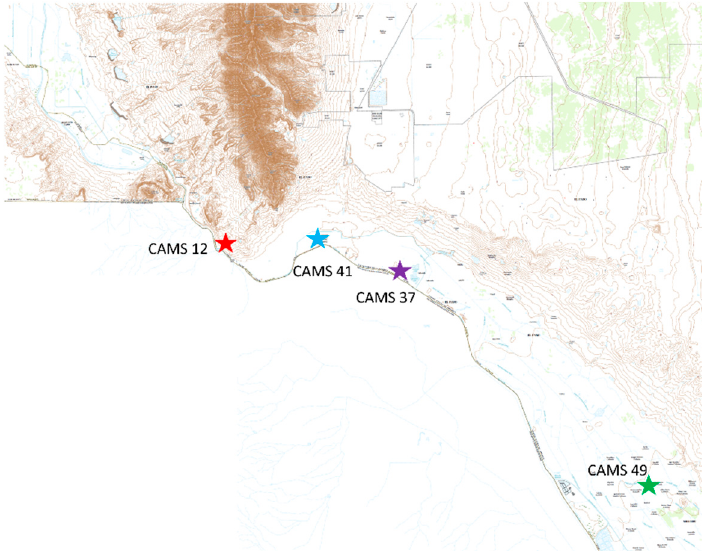
Figure 1. The geography of the El Paso region clearly showing apparent elevations in the downtown part and along the banks of the Rio Grande compared to the surroundings. Locations of the four major Texas Commission on Environmental Quality (TCEQ) Continuous Ambient Monitoring Stations (CAMS) sites used in this study. CAMS 12 and the ceilometer is at the University of Texas at El Paso (UTEP) (red), CAMS 41 at Chamizal Park (blue), CAMS 37 at Ascarate Lake (purple), and CAMS 49 at Socorro Hueco (green). Source: US Topo, USGS (www.usgs.gov/products/maps/topo-maps).